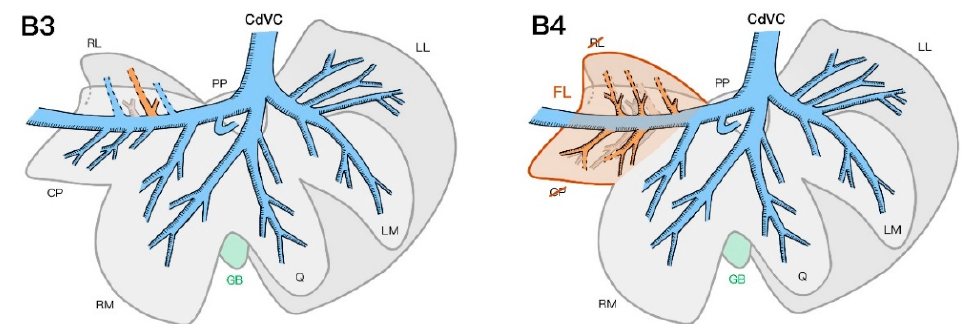
Figure 4. Schematic representation of the intrahepatic hepatic venous system with the most common number of tertiary branches and its anatomical variations from a parietal view. Most common hepatic venous pattern ( B1 ), additional vein to the left medial lobe from the central hepatic vein in 1/7 specimens ( B2 ), common trunk to the right lateral lobe and caudate process in 3/7 specimens ( B3 ), and fused caudate process and right lateral lobes in 2/7 specimens ( B4 ). CdVC, caudal vena cava; RHV, right hepatic vein; CHV, central hepatic vein; LHV, left hepatic vein; RL, right lateral; CP, caudate process caudate lobe; RM, right medial; GB, gallbladder; Q, quadrate; LM, left medial; LL, left lateral; PP, papillary process caudate lobe; FL, fused lobe.